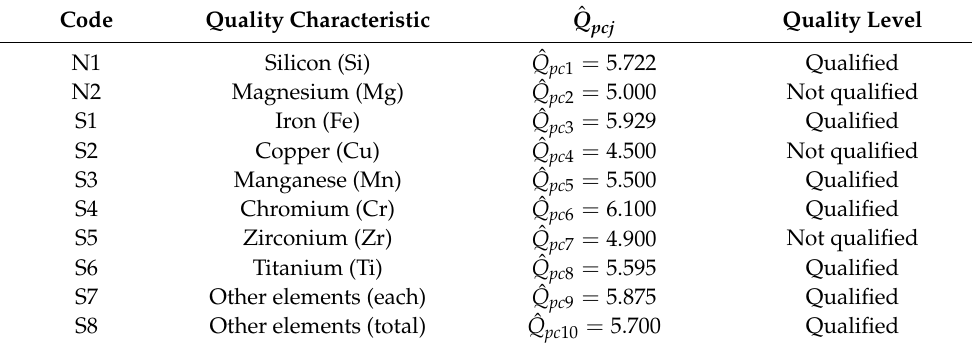
Table 5. The ˆ Q pcj of the adjusted 6063 aluminum alloy rods produced by Company H.